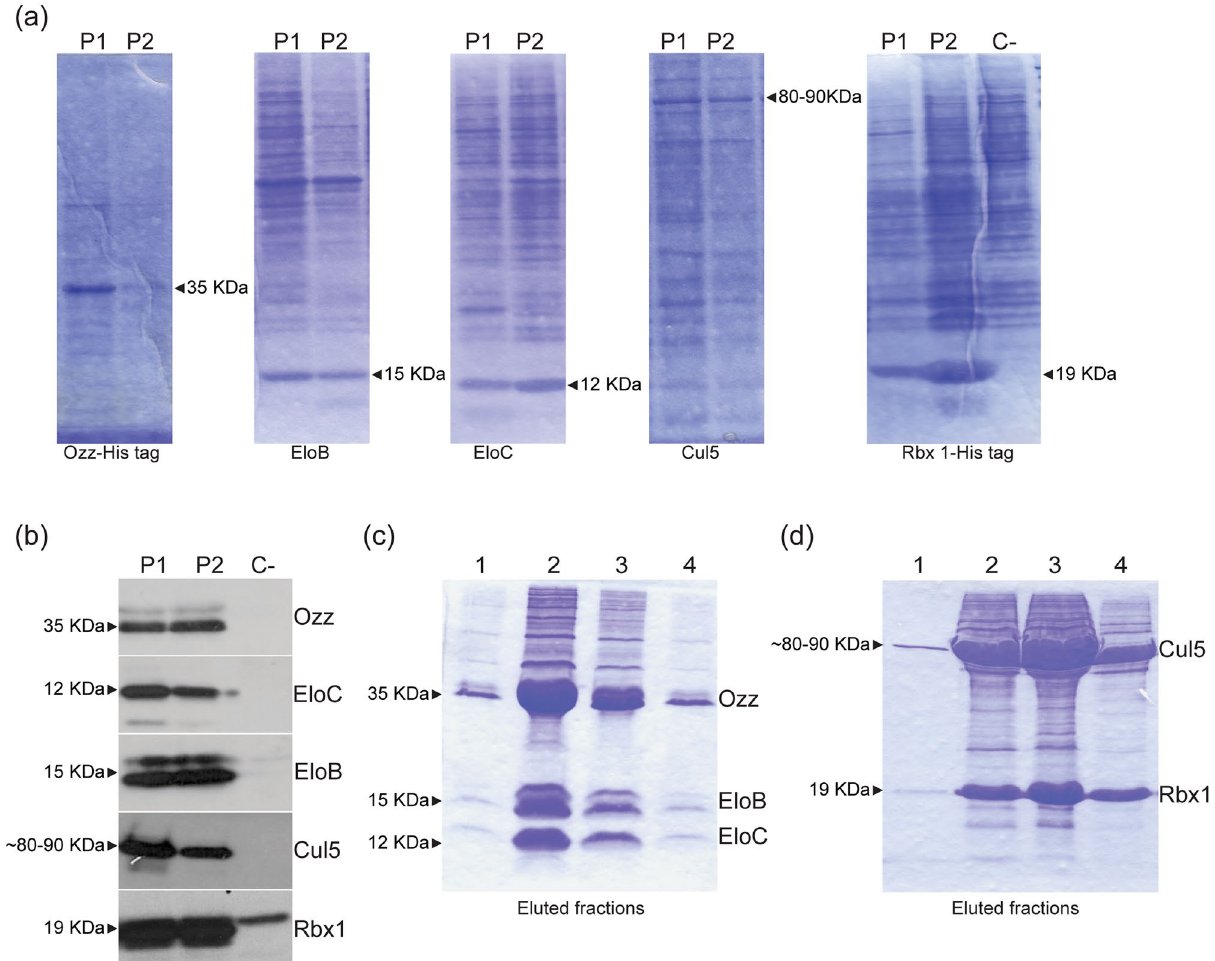
Figure 1. Expression and purification of CRL5 Ozz components. ( a ) Coomassie brilliant blue (CBB)–stained gels of baculovirus-produced Ozz (Plaque 1, Plaque 2), Elo B (Plaque 1, Plaque 2), Elo C (Plaque 1, Plaque 2), Cul 5 (Plaque 1, Plaque 2), and Rbx1 (Plaque 1, Plaque 2) from total lysates of individual plaques, compared to mock control (Control). ( b ) Western blot analysis of total lysates overexpressing the individual CRL5 Ozz components probed with of anti-Ozz, anti-Elo B, anti-Elo C, anti-Cul5 and anti-Rbx1 specific antibodies. ( c , d ) CBB-stained SDS ‐ polyacrylamide gels of Ni-NTA agarose affinity purified Ozz–EloBC and Cul5–Rbx1 Cul5–Rbx1 subcomplexes was subjected to immunoprecipitation using antibodies against Elongin C or Rbx1. Immunoprecipitated proteins were then separated on SDS–polyacrylamide gels and stained with SYPRO Ruby (Fig. 2e). The results demonstrated that Ozz–EloBC and Cul5–Rbx1 subcomplexes (Fig. 2a) indeed interact with each other and assemble into a 5-component CRL5 Ozz (Fig. 2e). We next fractionated the Ozz–EloBC and Cul5–Rbx1 subcomplexes, as well as the assembled CRL5 Ozz on Ruby. The fractionation profiles of the complexes and their protein components were generated by densitometric measurements of band intensities (Fig. 3a). Molecular weights were calculated based on the fractionation patterns